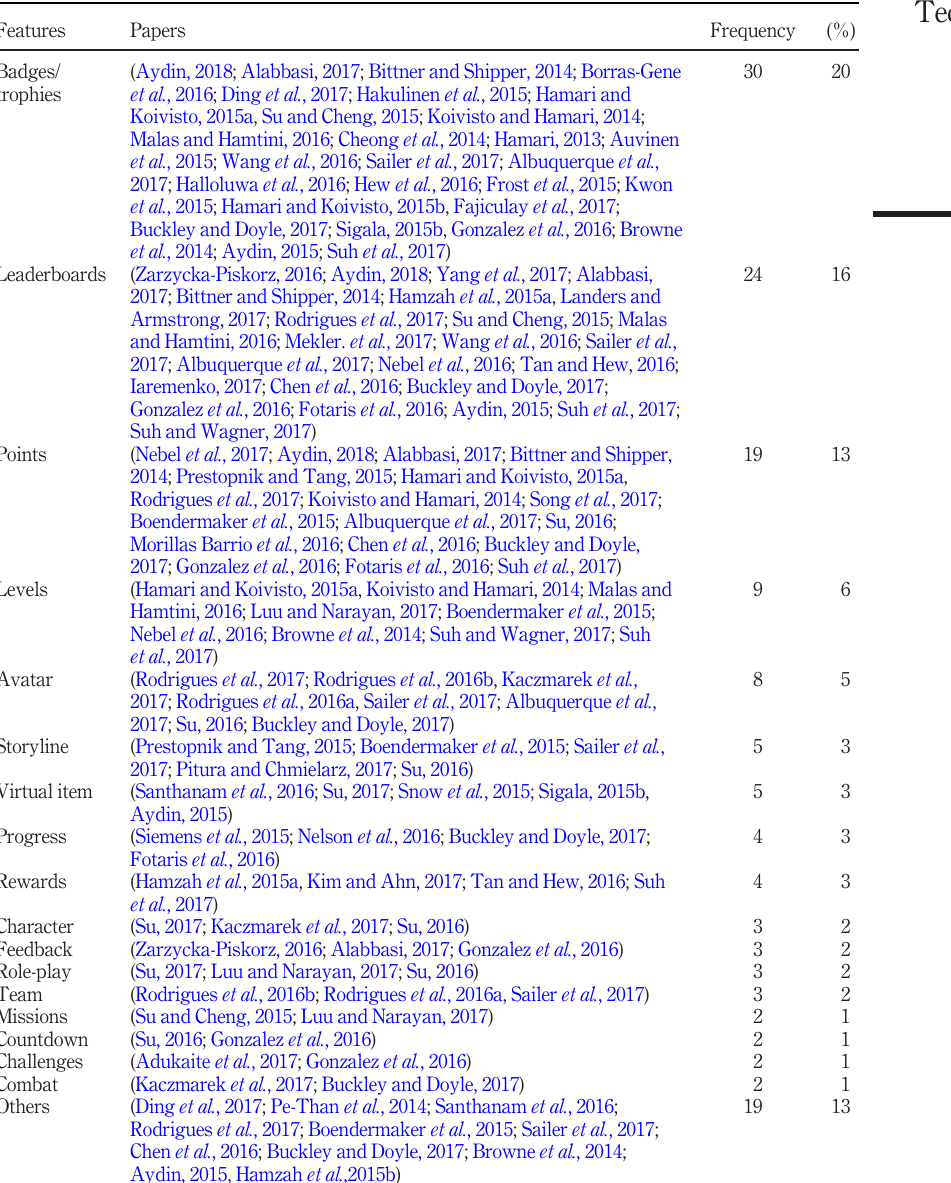
Table II. Game design